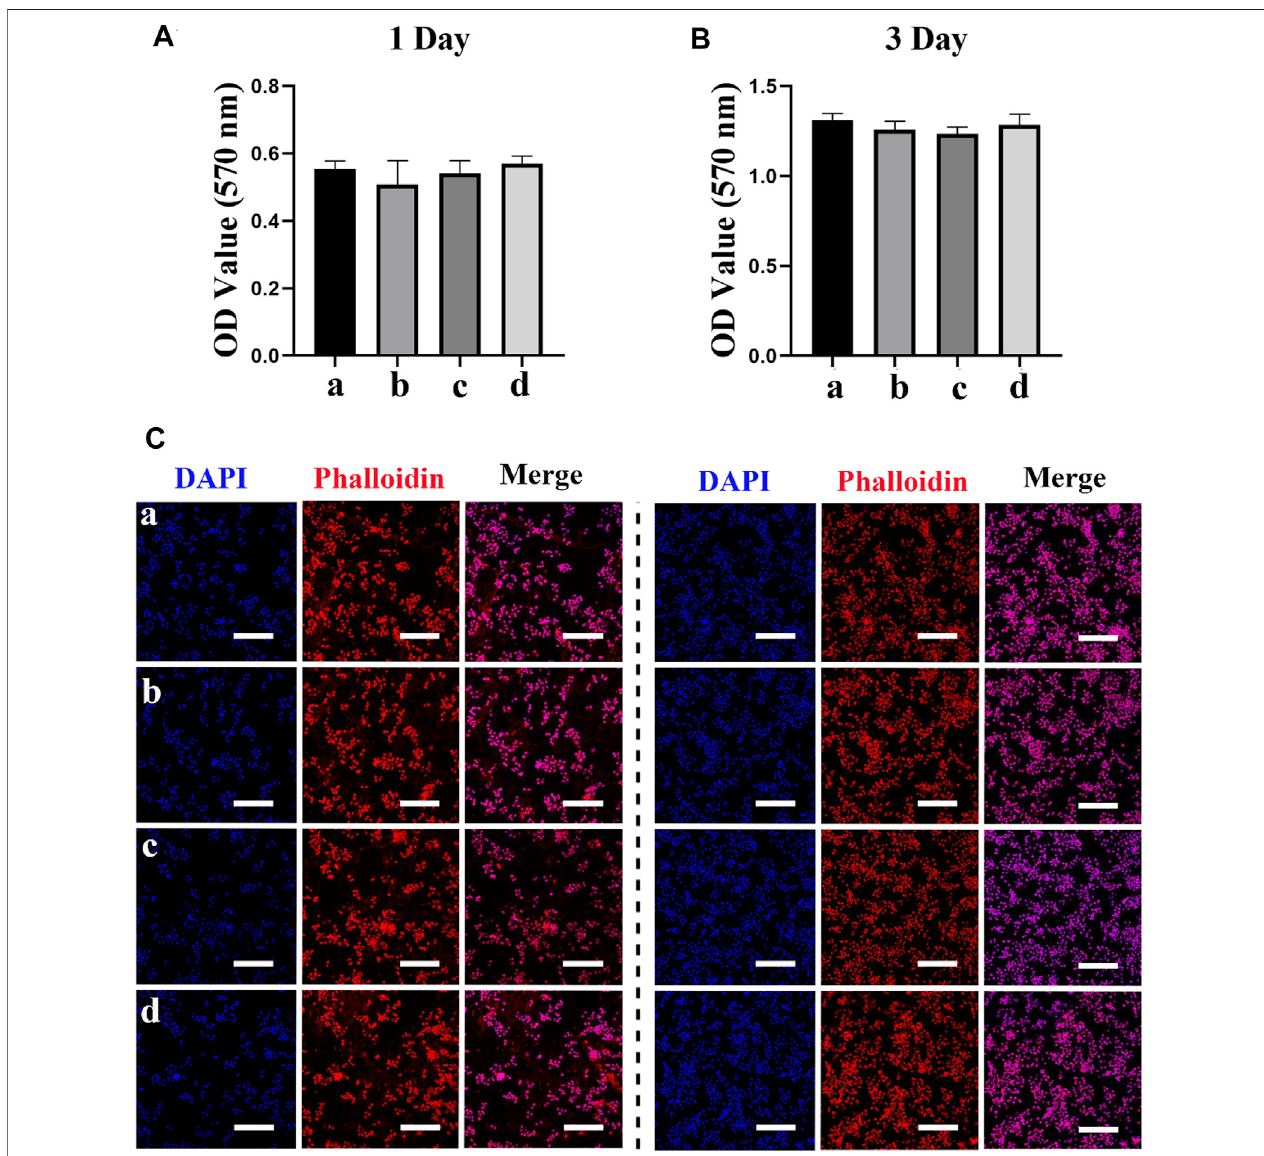
FIGURE 3 | Effect of the exosome and Ag hybrid scaffold on macrophages. (A,B) The cellular metabolic activity was determined by the MTT assay. a (cid:2) PCL/PDA, b (cid:2) PCL/PDA+Ag, c (cid:2) PCL/PDA+exosome, and d (cid:2) PCL/PDA+Ag+exosome. Results are shown as mean ± SD ( n (cid:2) 5). (C,D) Representative confocal microscopic images of RAW264.7 cocultured with the MSC-exosome and/or Ag hybrid scaffold at 1 day (C) and 3 days (D) . Cells were stained with Alexa Fluor 594-conjugated phalloidin (red) and nucleus (blue) ( n (cid:2) 3). Scale bars (cid:2) 200 μ m. Effect of the exosome and Ag hybrid scaffold on macrophage in fl ammatory response.